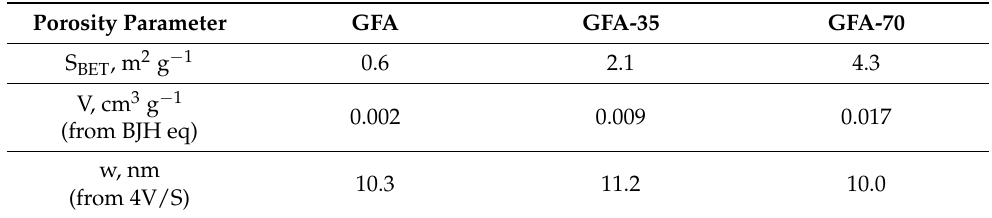
Table 1. Characteristics of the porous structure of graphite felt before thermal treatment in CO 2 atmosphere. Porosity